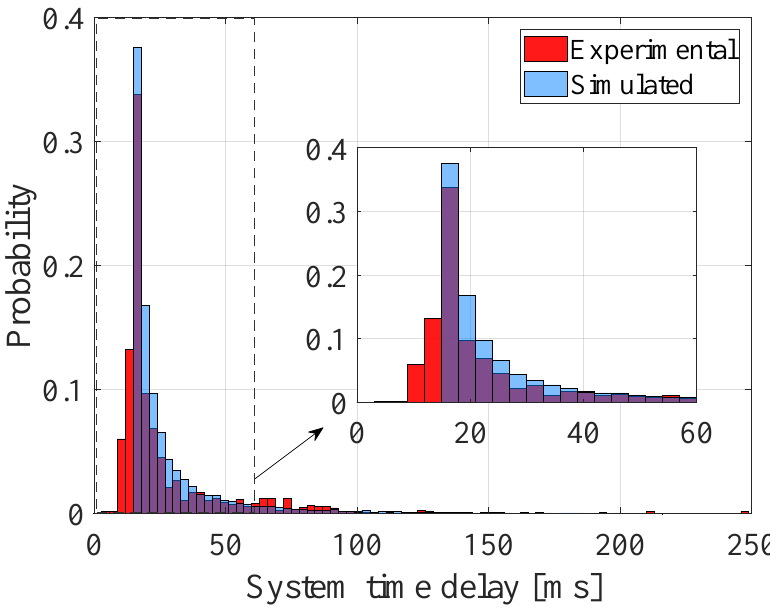
Figure 3. Histogram of system time delay. The red plots are measured data and the blue plots are simulated data by the approximate equation